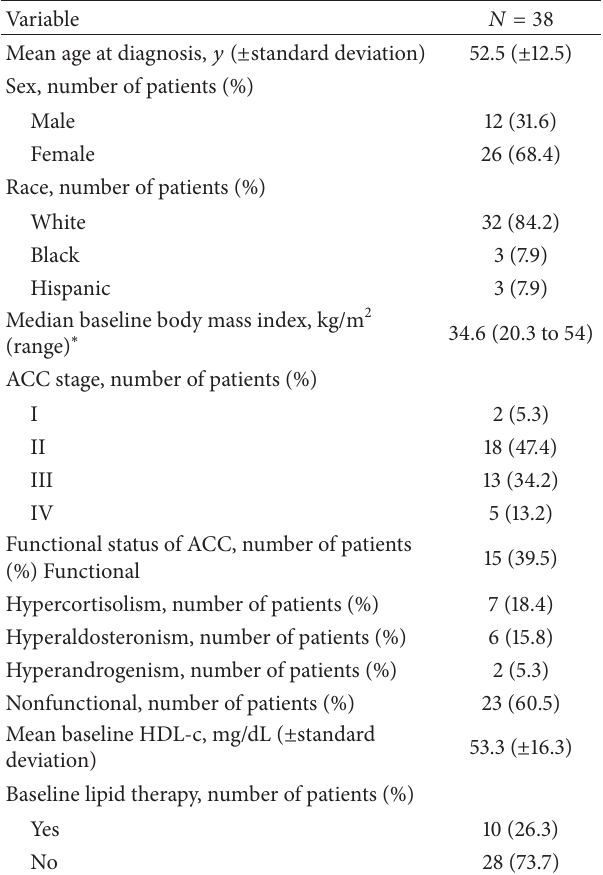
Table 1: Demographic and clinical characteristics of the study